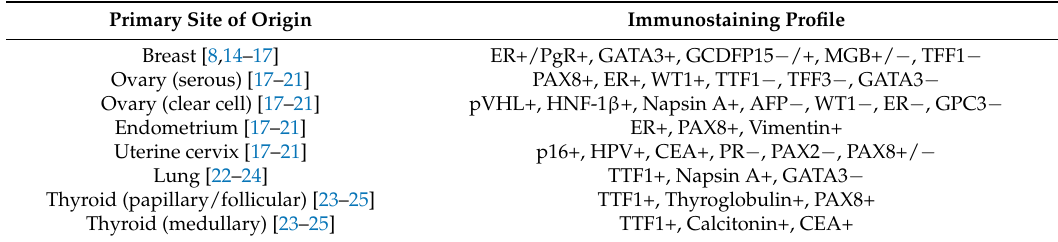
Table 2. Immunohistochemistry (IHC) tumour staining patterns in the differential diagnosis of CUPs expressing CK7+/CK20 −